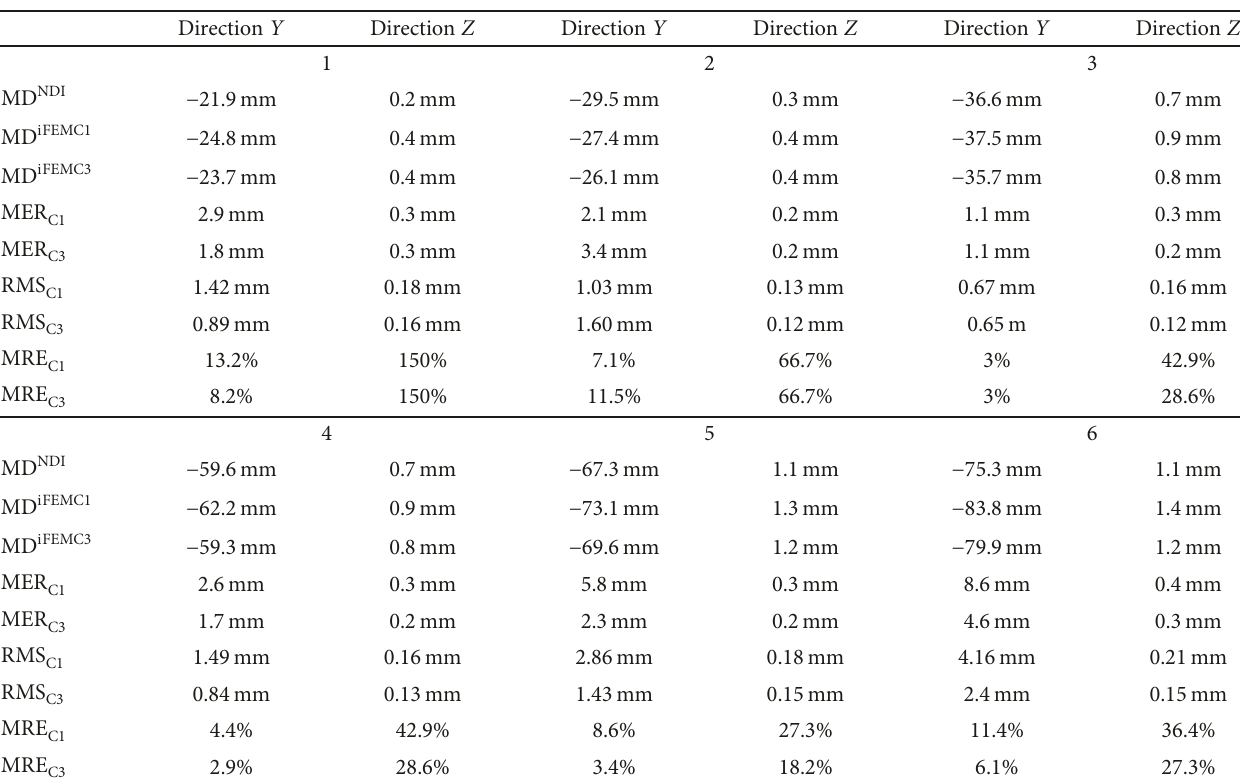
Table 6: Comparison between NDI and iFEM reconstructions in loading case of